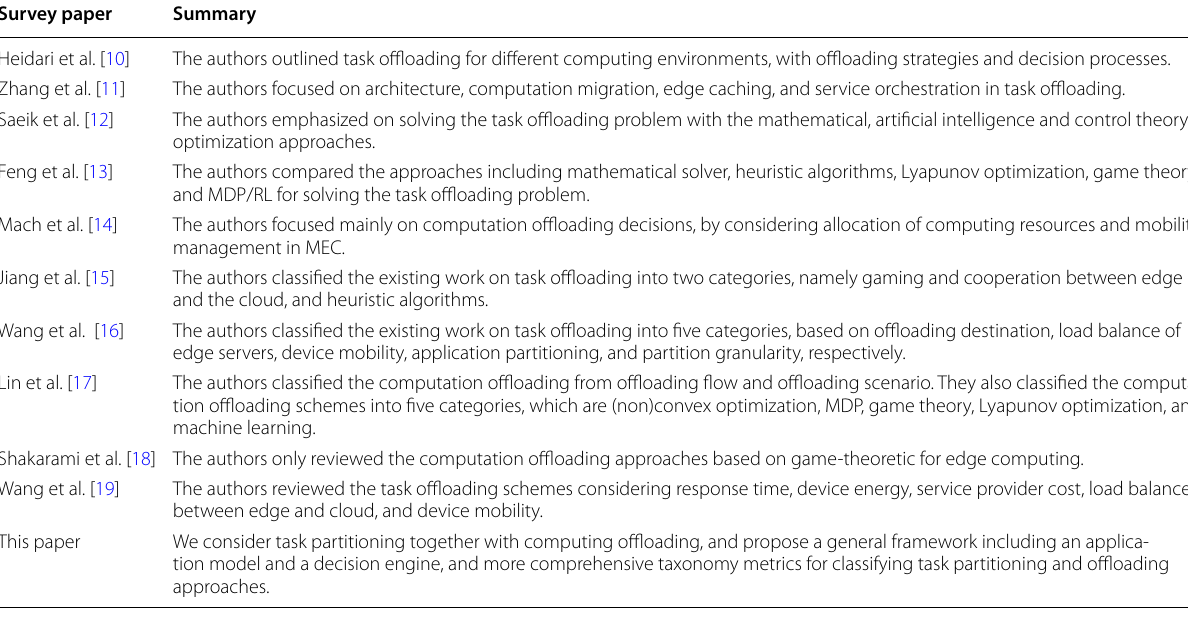
Table 1 Some existing surveys on computing offloading in edge